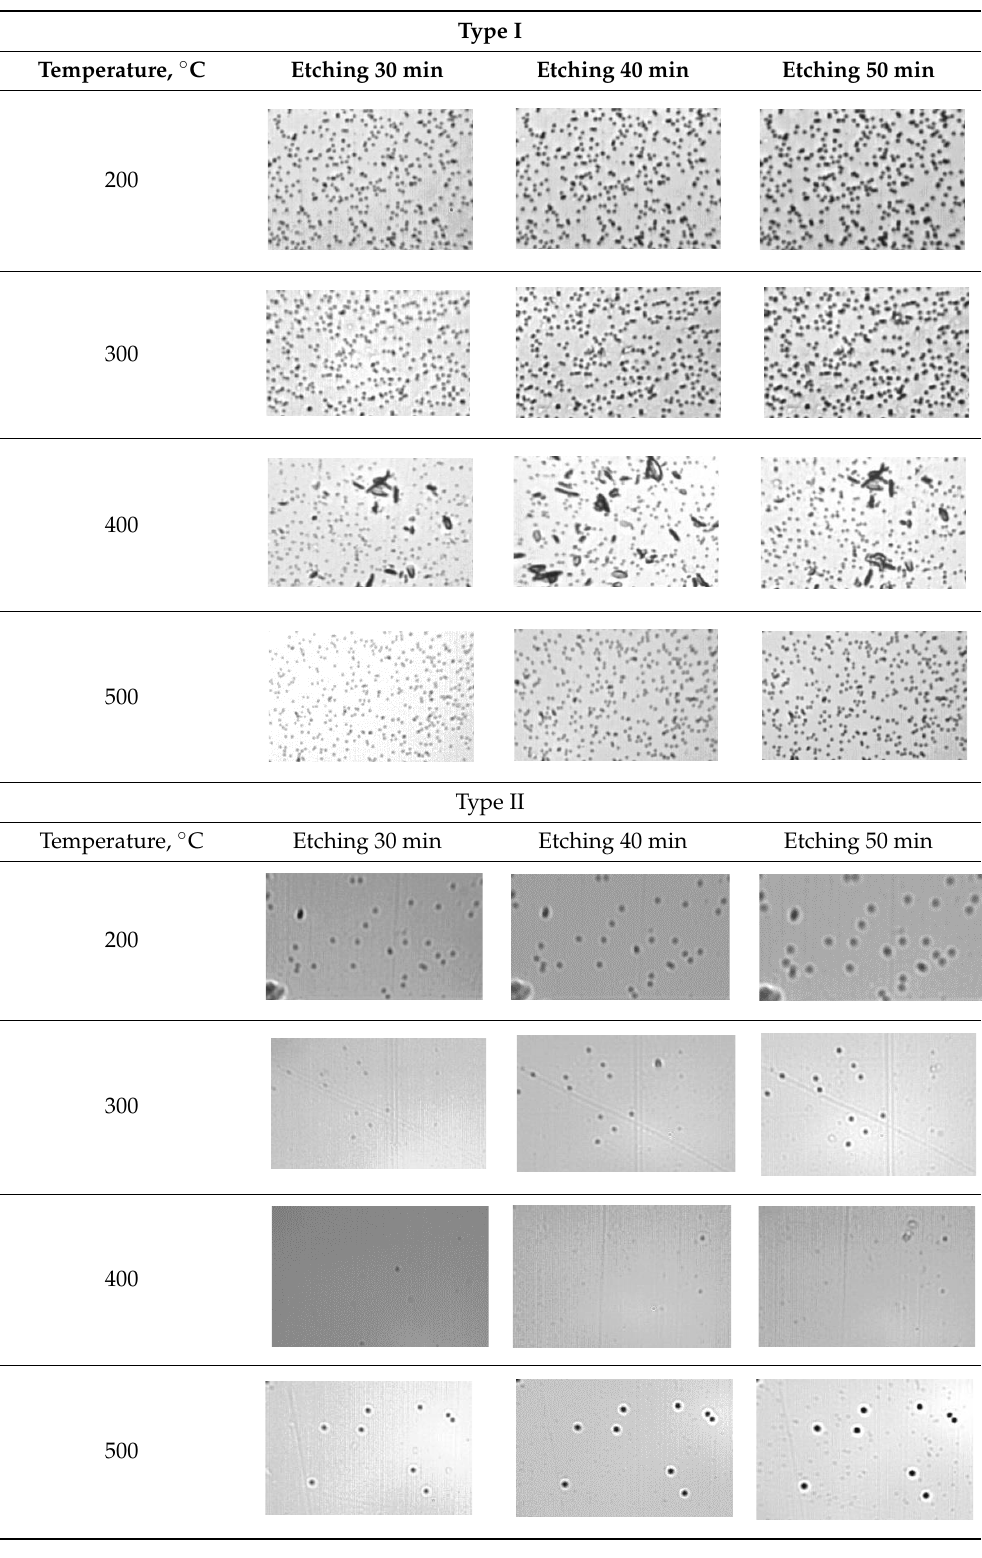
Table 1. The glass surface at different test conditions.